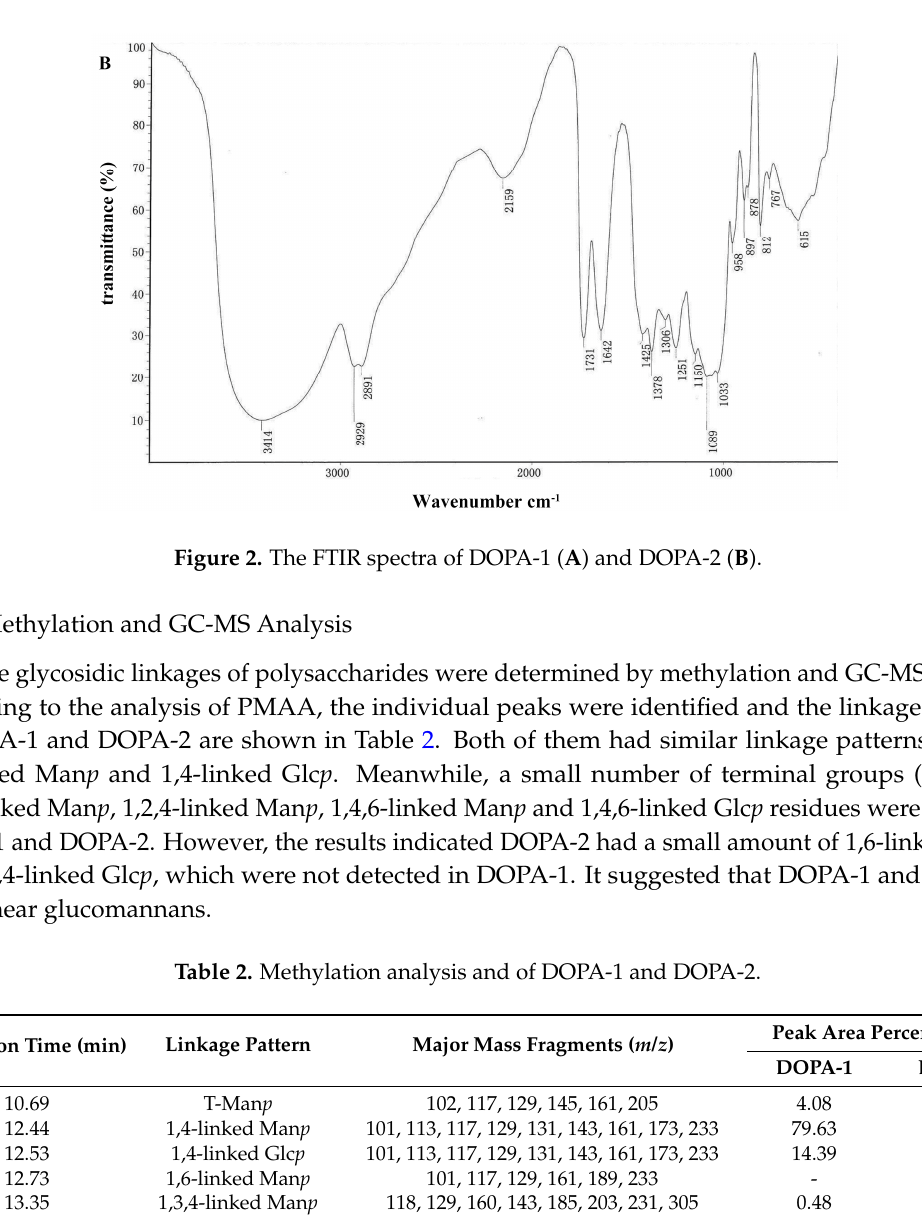
Table 2. Methylation analysis and of DOPA-1 and DOPA-2.